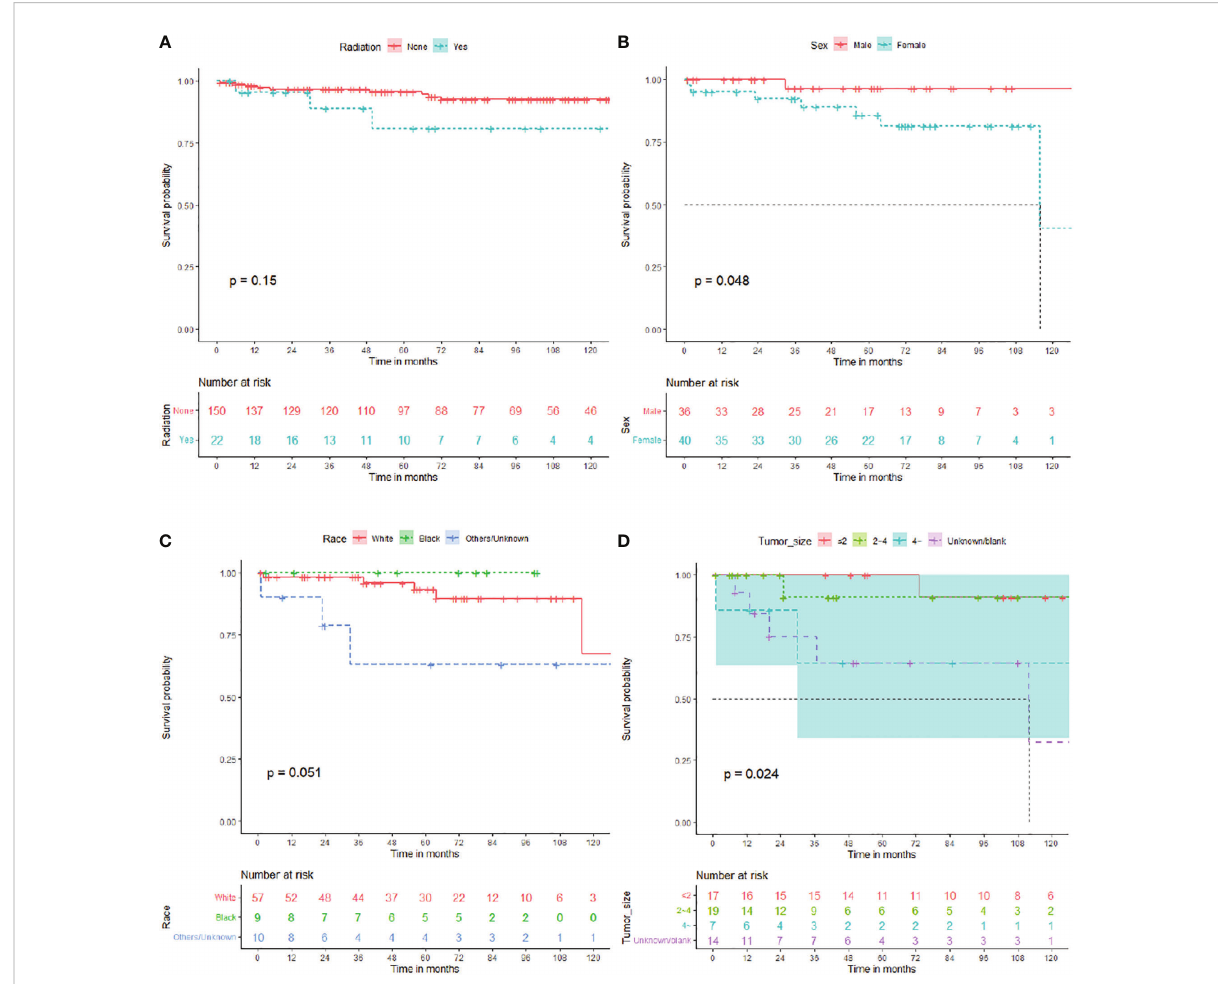
FIGURE 3 Overall survival (OS) for central neurocytoma in the gross total resection (GTR), subtotal resection (STR), and no surgery subgroups. (A) OS among the different radiotherapy groups in the GTR subgroup. (B) OS among the different sex groups in the STR subgroup. (C) OS among the different race groups in the STR subgroup. (D) OS among the different tumor size groups in the no surgery subgroup. OS, overall